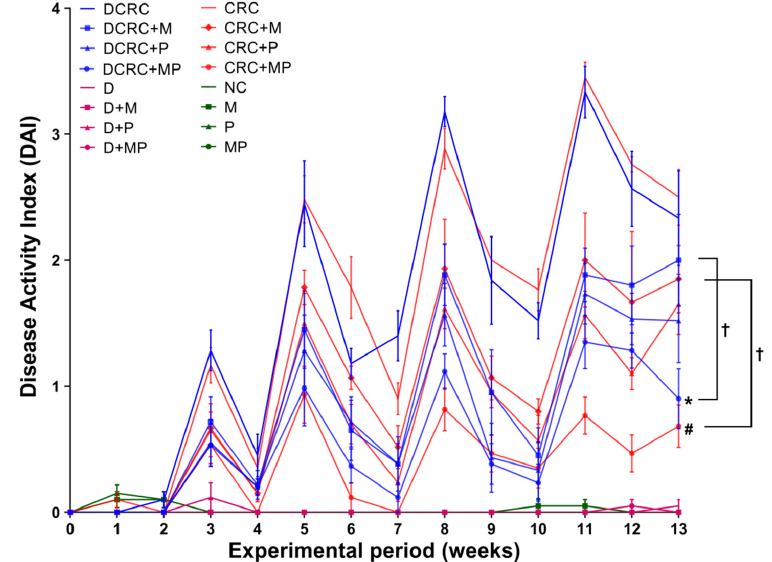
Figure 3. Weekly Disease Activity Index (DAI) variations among the different groups. Note that animals that were not subject to the induction of CRC had very low indexes, close to zero. However, an increase in DAI was obtained in the groups with CRC induction, with peaks obtained at week 3, 5, 8, and 11. M and P treatments elicited a reduction in DAI. Statistical significance was expressed by # p < 0.05 in nondiabetics when compared to their experimental CRC control (CRC), and by * p < 0.05 in diabetics when compared to their experimental diabetic CRC control (DCRC). Moreover, when comparing only two groups, connecting lines were used to indicate the compared groups with † p < 0.05. Cancers 2020 , 12 , x